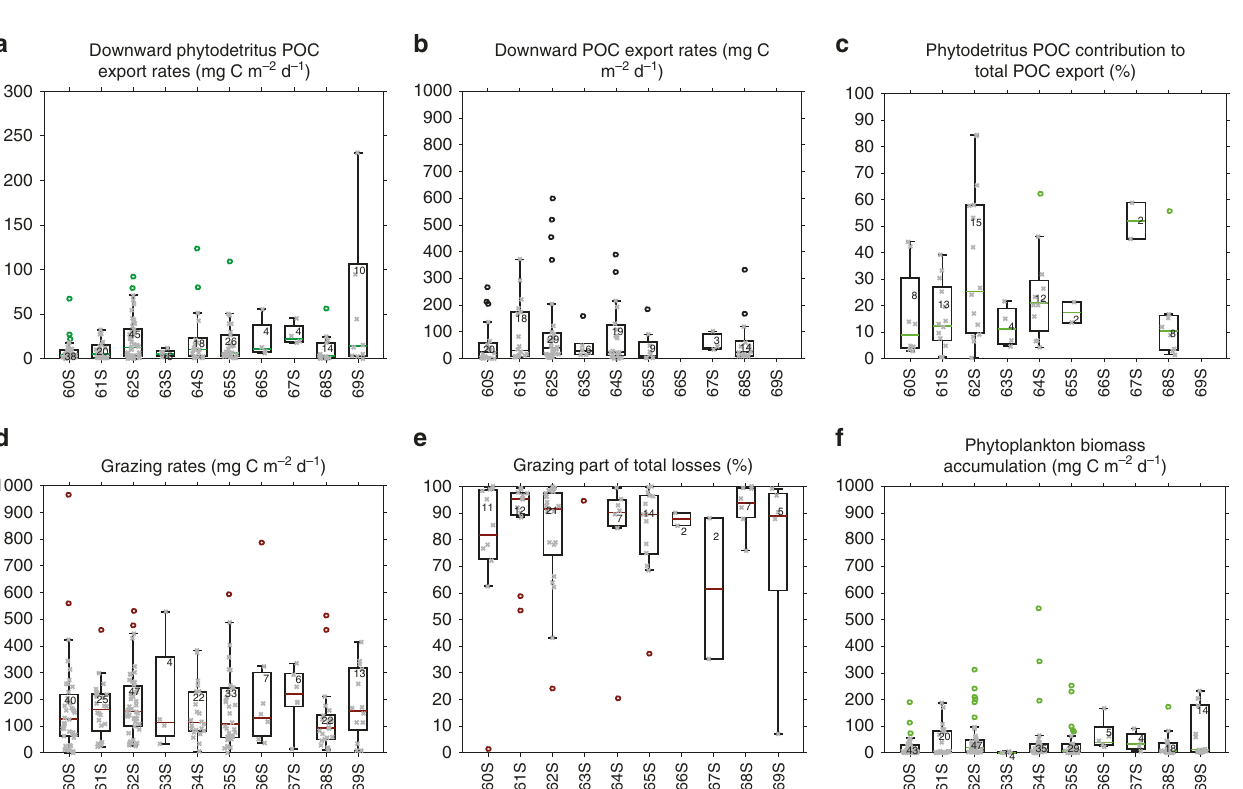
Fig. 5 Latitudinal distribution of phytoplankton fates. Box plot of integrated a phytodetritus POC export (mg C m − 2 d − 1 ), b POC export (mg C m − 2 d − 1 , no export values were reported at 66 and 69° S), c phytodetritus POC contribution to total POC export (%), d grazing (mg C m − 2 d − 1 ), e grazing part of total losses (%) and f phytoplankton biomass accumulation (mg C m − 2 d − 1 ). The box plot shows the median, the 50% central region, and the functional limits ([Q1 − 1.5 × IQR, Q3 + 1.5 × IQR], where Q1 and Q3 are the 25th and 75th percentiles respectively, and IQR is the interquartile range). Data are plotted as crosses and outliers as circles. The sample size is indicated for each